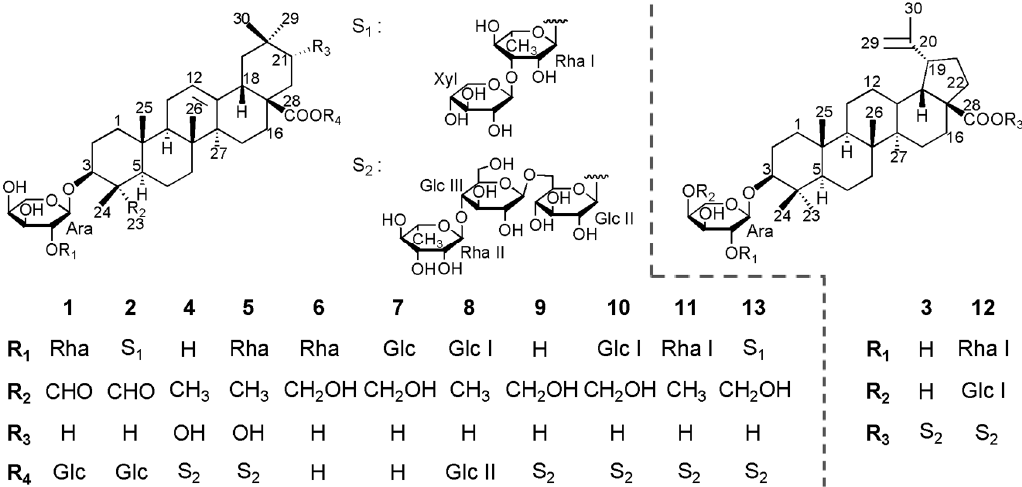
Figure 1. Structures of saponins 1 – 13 .